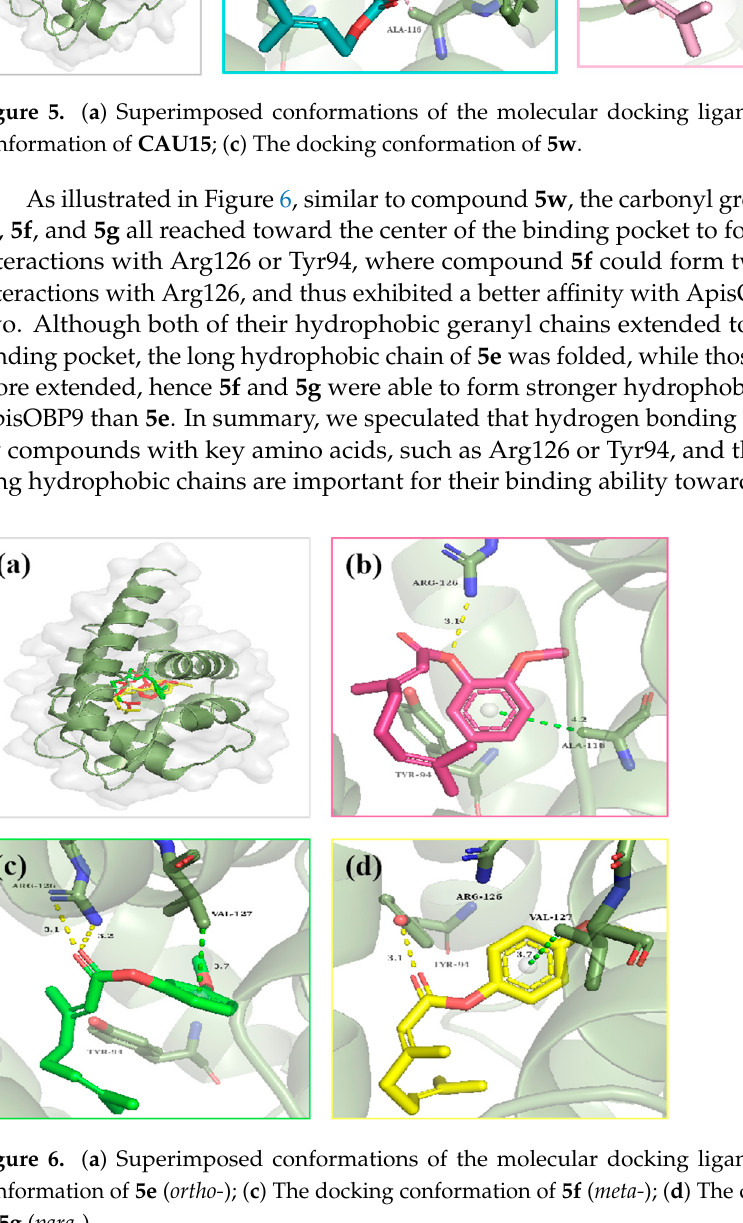
Figure 5. ( a ) Superimposed conformations of the molecular docking ligands; ( b ) The docking conformation of CAU15 ; ( c ) The docking conformation of 5w .